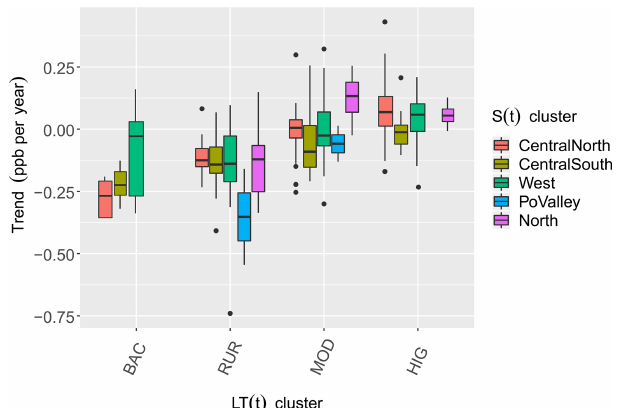
Figure 5. Box plots of deseasonalized daily mean O 3 trends for the LT (t) and S(t) clusters. LT (t) clusters represent a site-type classi- fication, while the S(t) clusters represent a geographical classifica- tion that is influenced by regional climate conditions. Boxes include 25th to 75th percentiles with the line indicating the median value; whiskers extend to 1.5 times the interquartile